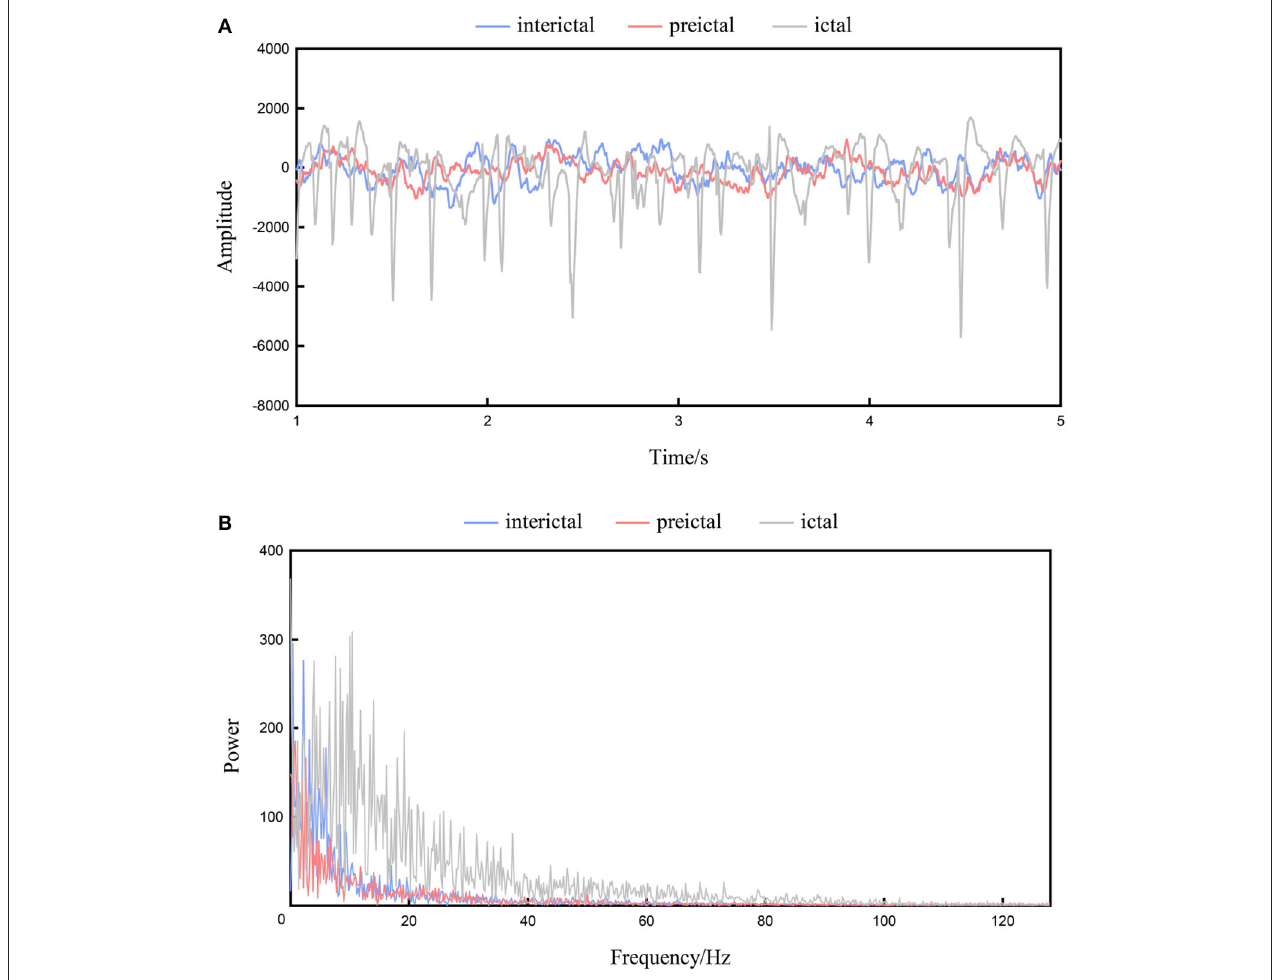
FIGURE 1 | The interictal, preictal and ictal recordings from patient 1. (A) Recordings of the time domain. (B) Recordings of the frequency